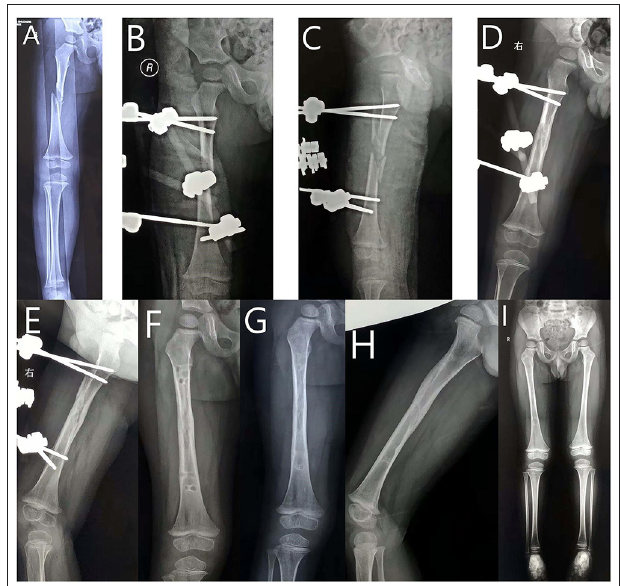
FIGURE 2 | Seven-year-old boy with right femoral shaft fracture treated with an external fixator. (A) Anteroposterior (AP) view of the right femur before surgery. (B) AP view of the right femur after surgery. (C) Lateral view of the right femur after surgery. (D) AP view of the right femur at 6-week follow-up. (E) Lateral view of the right femur at 6-week follow-up. (F) AP view of the right femur at 9-week follow-up. (G) AP view of the right femur at 6-month follow-up. (H) Lateral view of the right femur at 6-month follow-up. (I) AP view of the lower limbs at 18-month